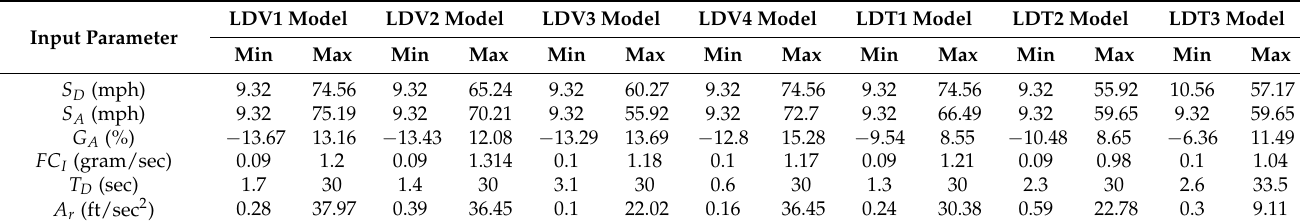
Table 2. Values of the input parameters used in the training sets.